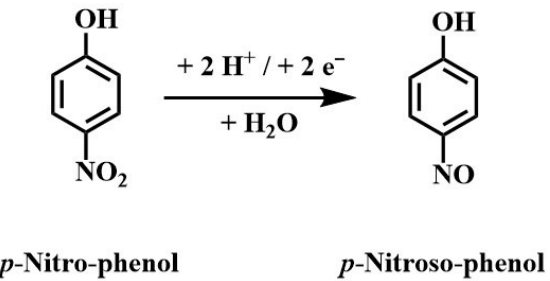
Scheme 1. Schematic of the reduction mechanism of 4-NP on the f-NC2/GCE.